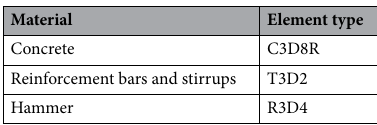
Table 2. Element type in ABAQUS software.